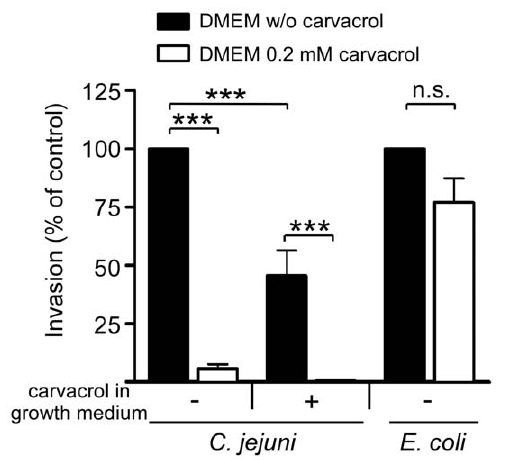
Figure 5. Effect of carvacrol on bacterial invasion of INT-407 cells. Invasion of INT-407 cells by C. jejuni (strain 108) and E. coli inv in the absence (filled bars) and presence (open bars) of 0.2 mM of carvacrol. Bacteria used for inoculation were grown in HI broth without ( 2 ) or with ( + ) carvacrol. Invasion was determined using the gentamicin protection assay. Note that the reduction in invasion was specific for C. jejuni and most effective when carvacrol was present before and during the infection assay. Results are expressed as percentage of invasion in the absence of carvacrol and are mean values 6 standard error from at least three independent experiments. *** p # 0.001; n.s. not statistically significant.